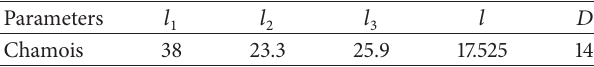
Table 2: Parameter of the mechanism (unit: mm).